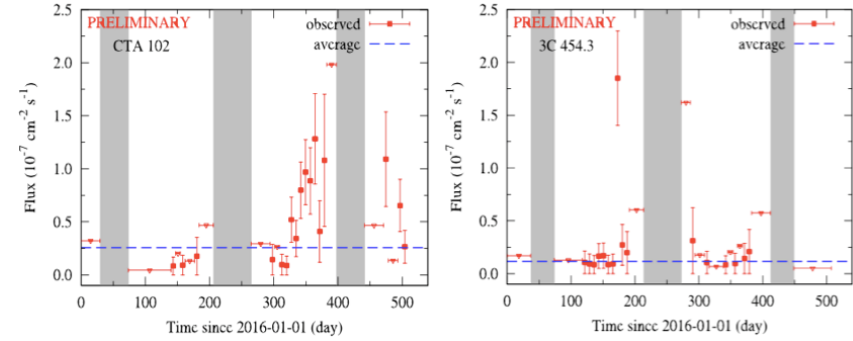
Figure 7. The light curves for two active galactic nuclei (left: CTA 102, right: